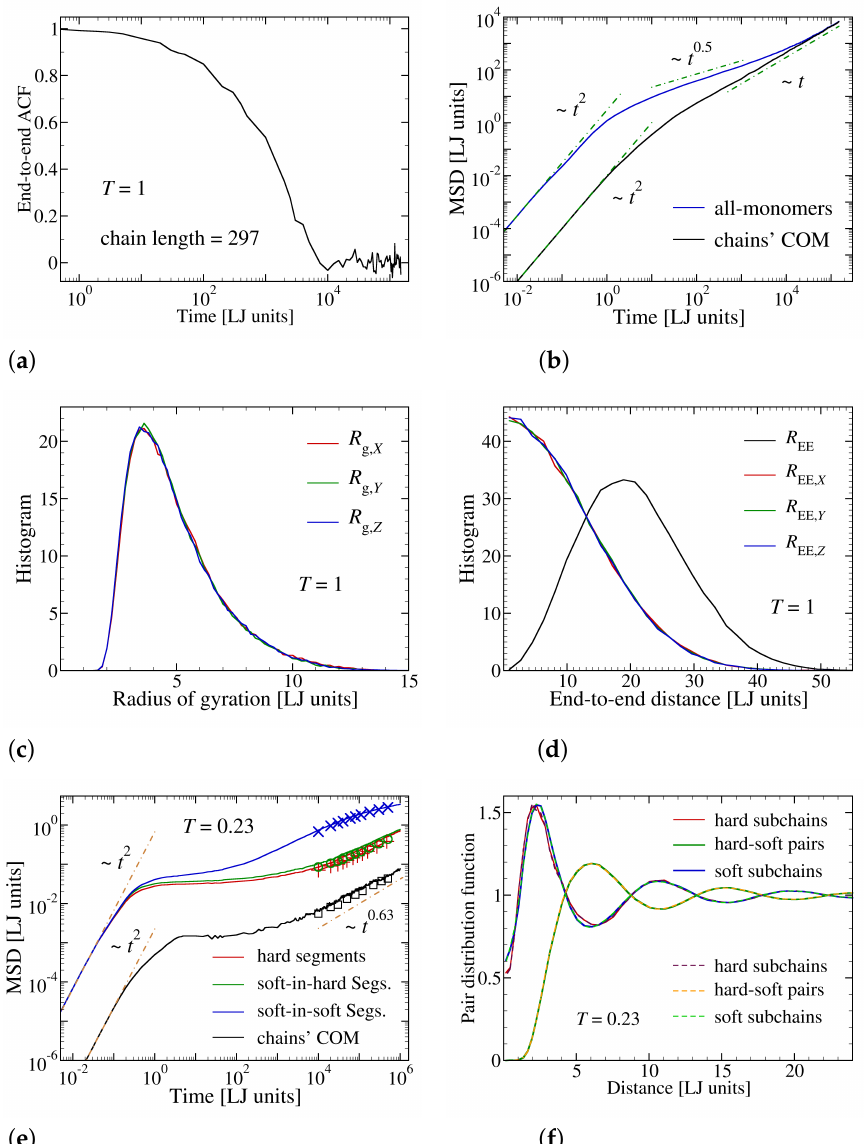
Figure 2. ( a ) Auto-correlation function of end-to-end vector during the initial equilibration step via soft potential approach of Parker and Rottler [64]. ( b ) Mean-squared displacement for all monomers and chains’ center of mass (COM) during the same stage as in ( a ). The short time ballistic ( ∼ t 2 ) and long time diffusive ( ∼ t ) regimes are also highlighted. The histogram for projections of ( c ) gyration tensor and ( d ) end-to-end vector along different directions show perfect isotropy. ( e , f ) Dynamic and static properties of the model after replacing the soft potential by the LJ-excluded-volume interactions. ( e ) Mean-squared displacements of different components plotted for the full model in the absence of additive at T = 0.23 ( < T g ≈ 0.25, see Figure 3). The emergence of a quasi-Rouse-like dynamics, is visible ( ∼ t 0.63 ). The symbols show dynamic measurements using t 0 = 10 5 τ LJ (note that MSD are plotted versus t − t 0 ). The observed difference in the dynamics for t 0 = 0 (lines) and t 0 = 10 5 τ LJ (Symbols) is a signature of an ongoing aging. This effect is, however, weak and can be neglected as compared to the effects of temperature and additive molecules. ( f ) Pair distribution function for hard and soft subchains, averaged over a first time interval of t ∈ [ 0,10 5 τ LJ ] (solid lines) and a second one t ∈ [ 10 5 τ LJ ,2 × 10 5 τ LJ ] (dashed lines), highlighting that the structure is hardly changed during aging. An anti-correlation is visible between the self and cross terms. This can be regarded as a consequence of the phase separation between the regions of hard and soft segments (Figure